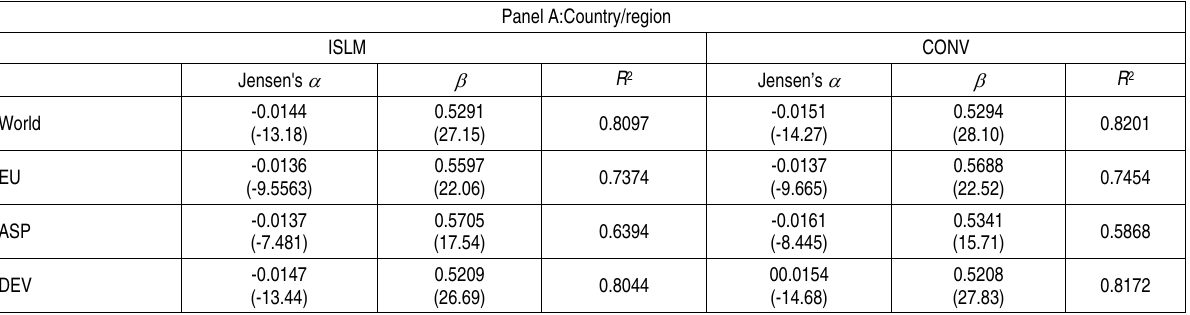
Table 6. Estimations of CAPM